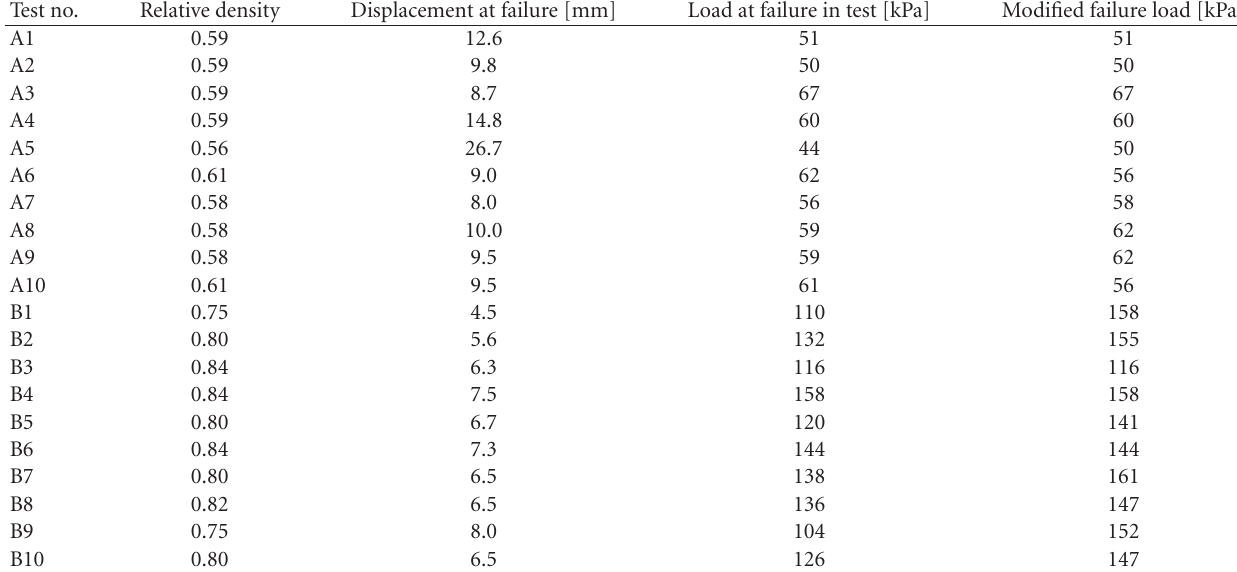
Table 4: Failure loads from tests.